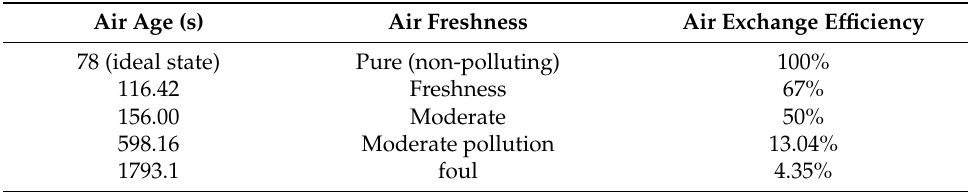
Table 2. Evaluation indicators for kitchen air